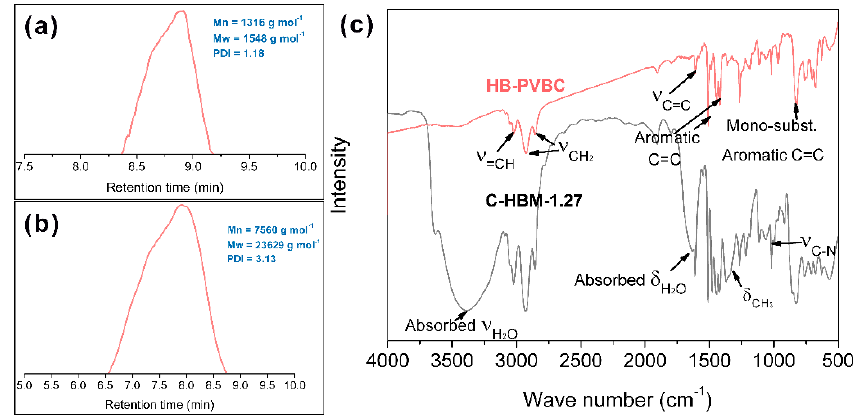
Figure 2 . Gel permeation chromatography (GPC) traces of polyamine poly( N,N - Figure 2. Gel permeation chromatography (GPC) traces of polyamine poly( N , N -Dimethylbenzylamine) Dimethylbenzylamine) ( a ) and the hyperbranched oligomer HB-PVBC ( b ); IR spectra of oligomer HB- ( a ) and the hyperbranched oligomer HB-PVBC ( b ); IR spectra of oligomer HB-PVBC and membrane PVBC and membrane C-HBM-1.27 ( c ). PDI, polydispersity. C-HBM-1.27 ( c ). PDI,